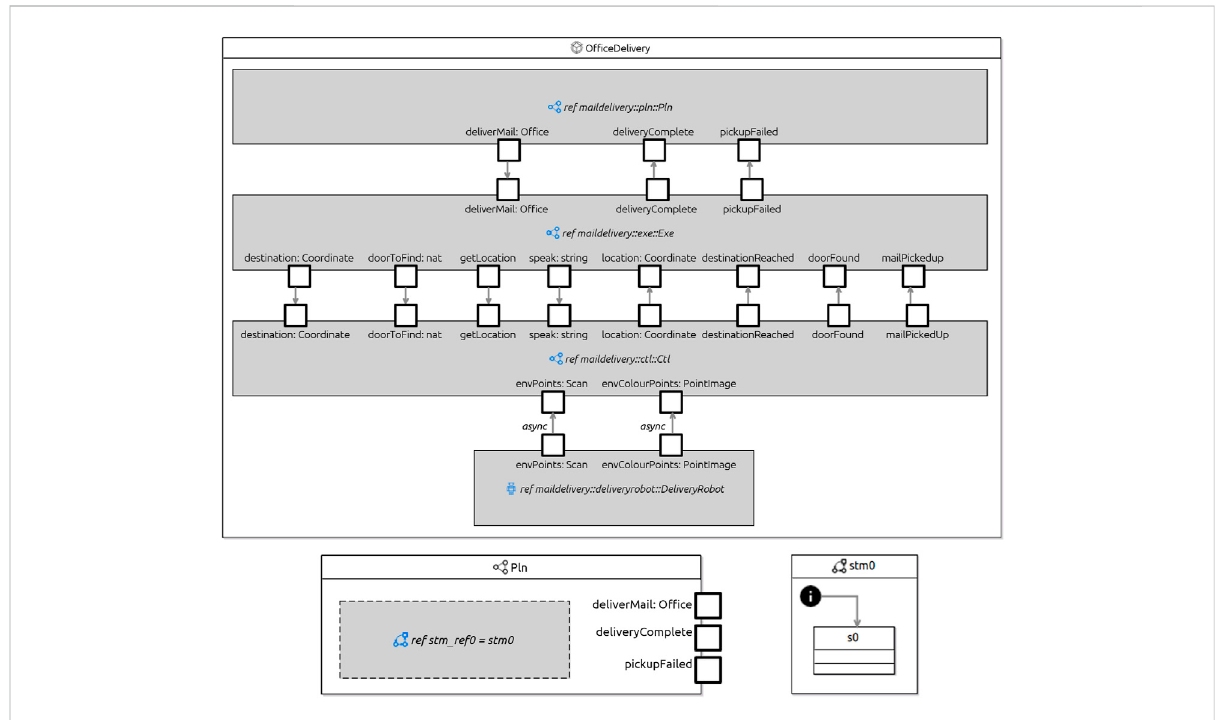
FIGURE 4 Delivery robot in